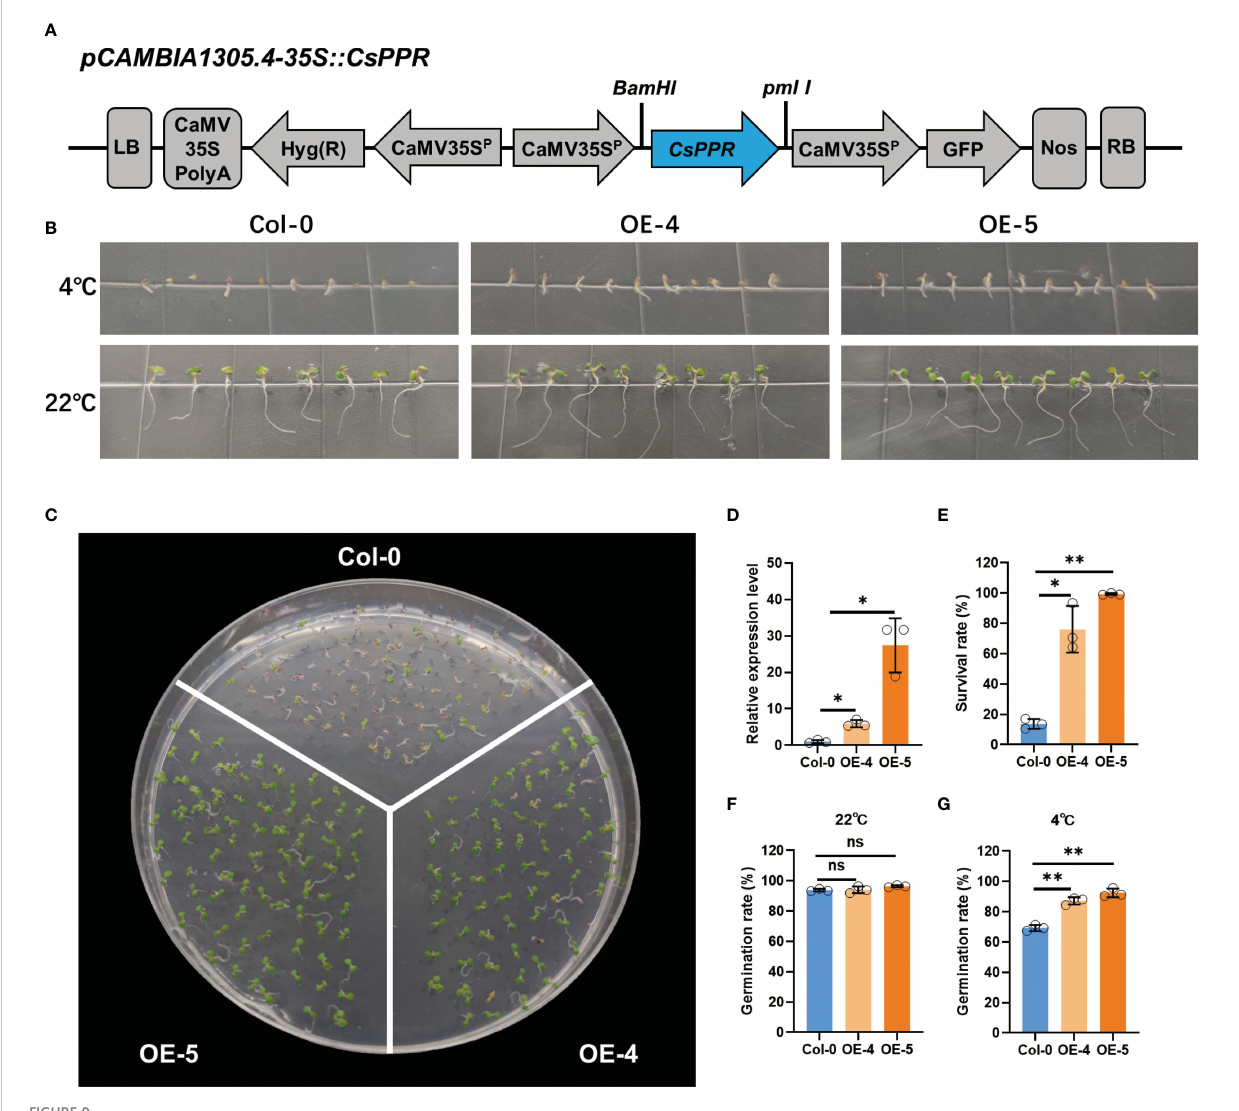
FIGURE 9 Low temperature tolerance of transgenic A.thalina ectopically expressing CsPPR . (A) Schematic diagram of the CsPPR construct for A.thaliana transformation. LB: Left border; CaMV35SPolyA: untranslated region of the CaMV 35S gene; hyg (R): Hygromycin phosphotransferase gene that confers hygromycin resistance; CaMV35Sp: CaMV 35S promoter; CsPPR : full-length of cucumber CsPPR ; GFP: green fl uorescent protein; NOS: transcriptional terminator sequence of the nopaline synthase gene; RB: right border. (B) Phenotype of the Col-0, CsPPR -expressing plants exposed to 4°C for 20 days and 22°C for 5 days. WT, wild-type (C) Phenotypes of acclimated WT, OE-4 and OE-5 plants exposed to 4°C for 40 days. At least three plates were used per treatment. (D) qRT-PCR showing the relative expression level of CsPPR in three independent CsPPR- ectopically expressing transgenic lines OE-4 and OE-5. Error bars represent the standard deviation of three replicates. (E) Survival rates after 4°C for 40 days. The data are the mean ± SD values of three independent experiments. Germination rates of the Col-0, OE-4 and OE-5 seeds germinated on 1/2 MS medium after (F) 5 days at 22°C, and (G) 20 days at 4°C. For (F, G) the data shown is the mean ± SD (n=50~100) of three replicates, with the error bars representing the standard deviation. The asterisks indicate the statistically signi fi cant differences of expression between control and transgenic lines. “ ** ” represents “ p<0.01 ” , “ * ” represents “ p<0.05 ”